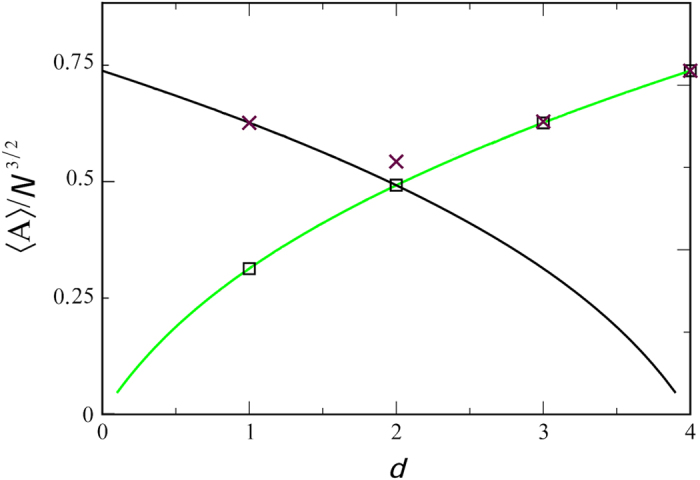
The theory for the normalized average area, 〈A〉/N3/2, under the Bessel excursion (solid black line) and reflected Bessel bridge (solid green line), provided by the + and − branches of Eq. (12), respectively.N is the number of steps in the random walk. The simulation results for the IR (black squares) and LIR (brown crosses) models for d = 1, 2, 3, 4 matches our expectations, namely a good fit to theory for all but the LIR case at d = 2, which do not converge even for N = 106, as this is the critical dimension for this case.